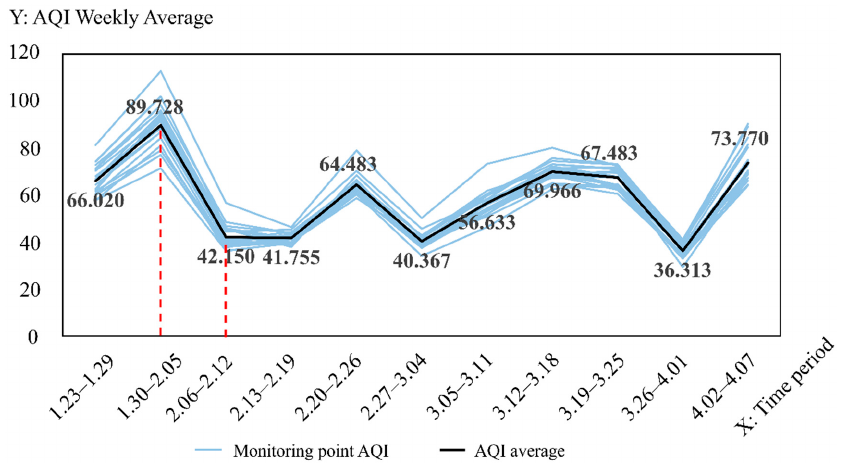
Figure 2. Wuhan AQI weekly change folding chart during the city closure in